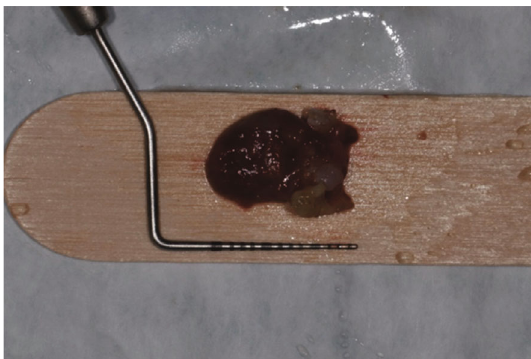
Figure 7: Lesion with millimeter